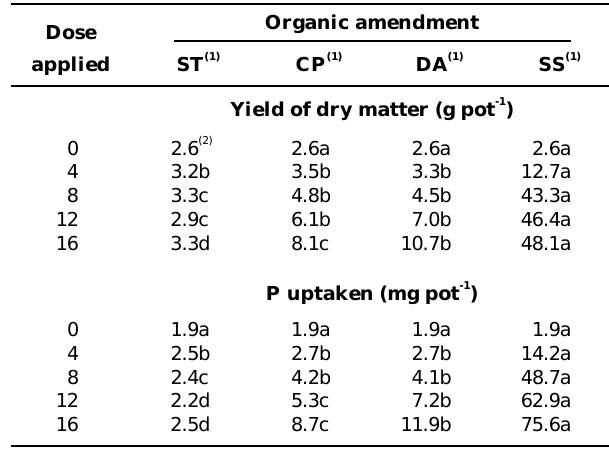
Table 2. Effect of four organic amendments on the yield of dry matter and P uptaken by corn plants grown on the Hoda